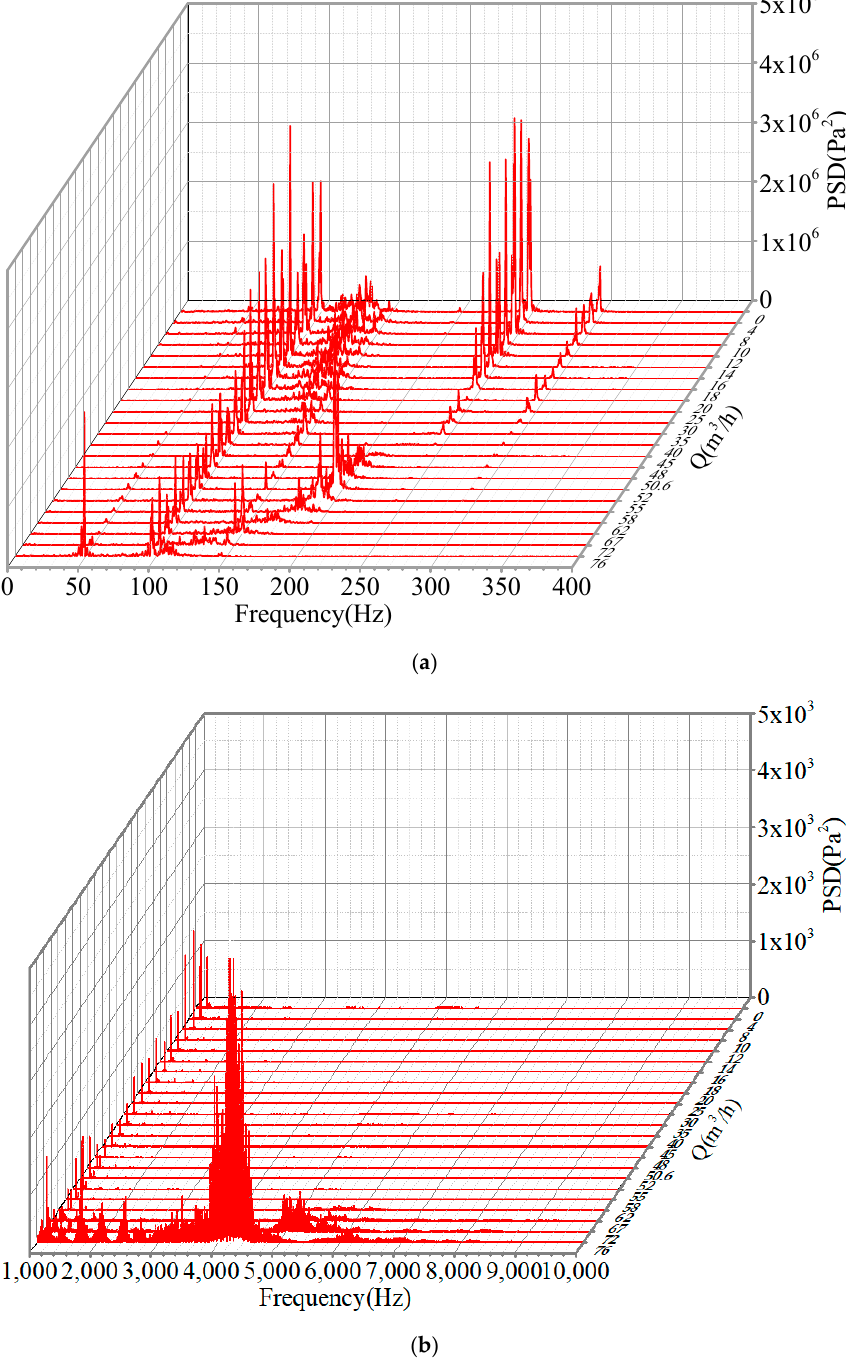
Figure 17. PSD of the acoustic pressure measured by pump outlet hydrophone 1 at different flow rates. ( a ) 0–400 Hz; ( b ) 1–10 kHz.